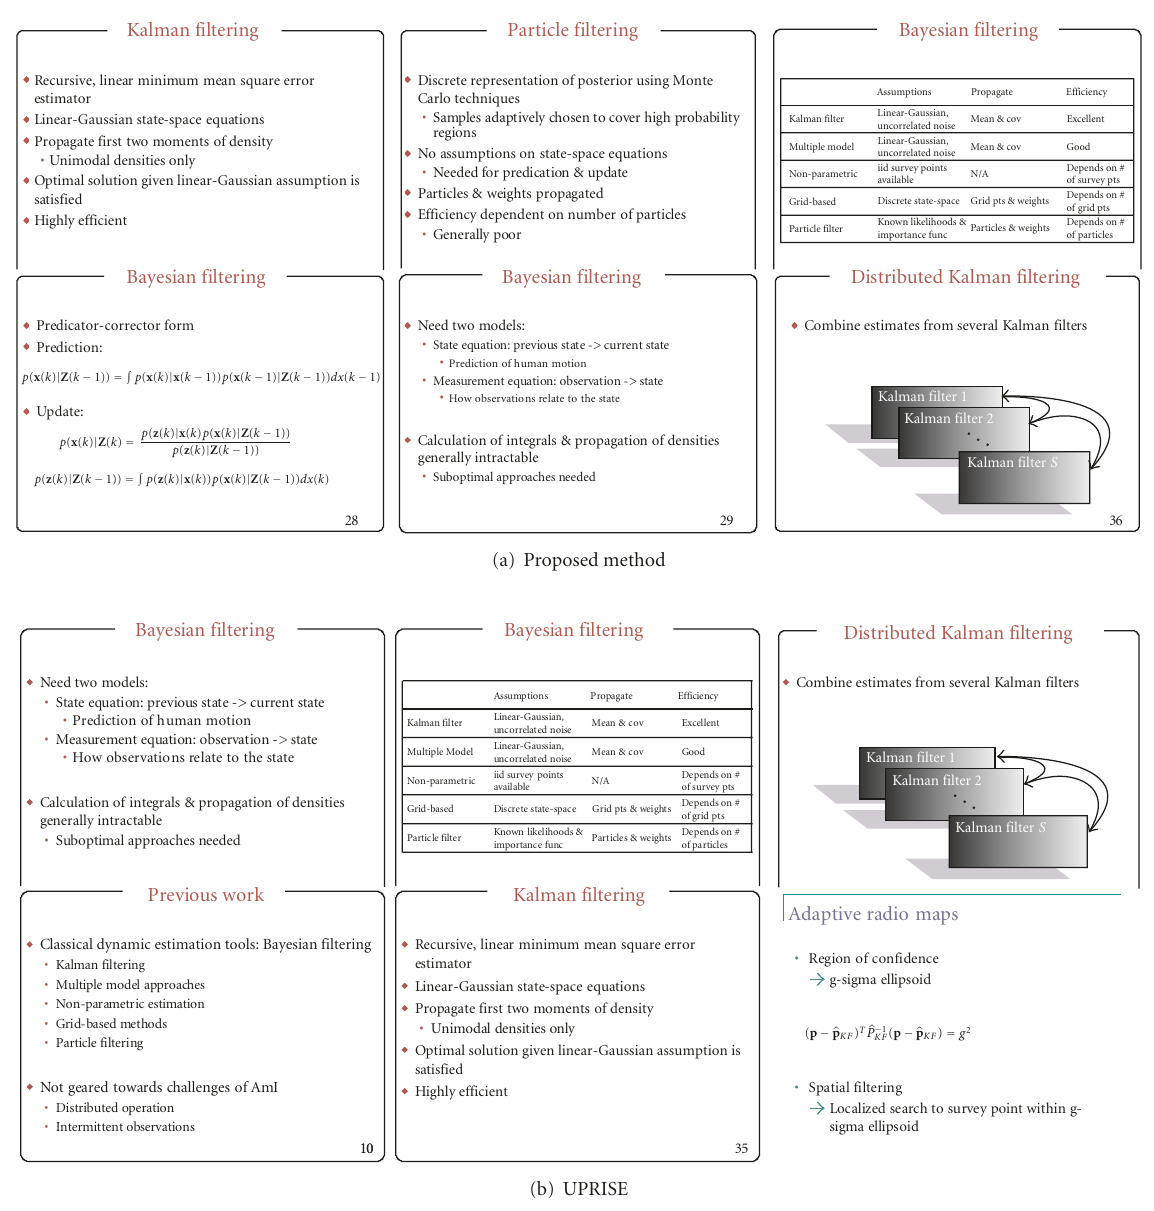
Figure 16: Example of retrieval results for the query term filtering : (a) the proposed method, (b)